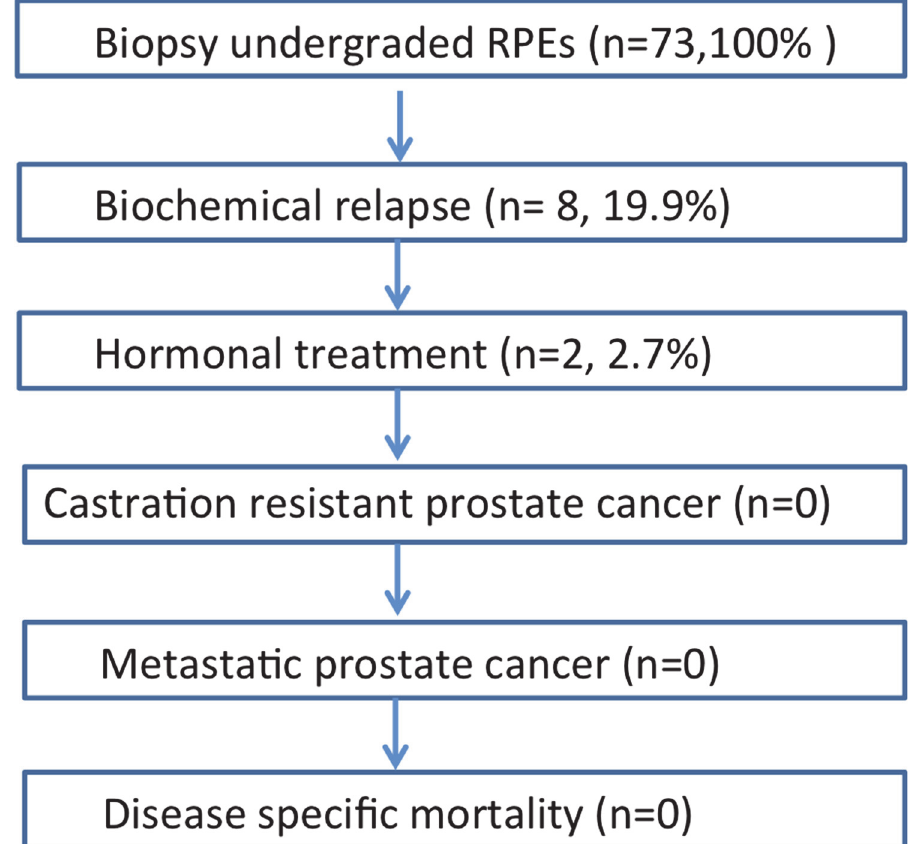
Fig 1. Follow up of biopsy-undergraded patients treated with radical prostatectomy, n = 81, 7 patients´ follow up missing ! n = 73, 100%.